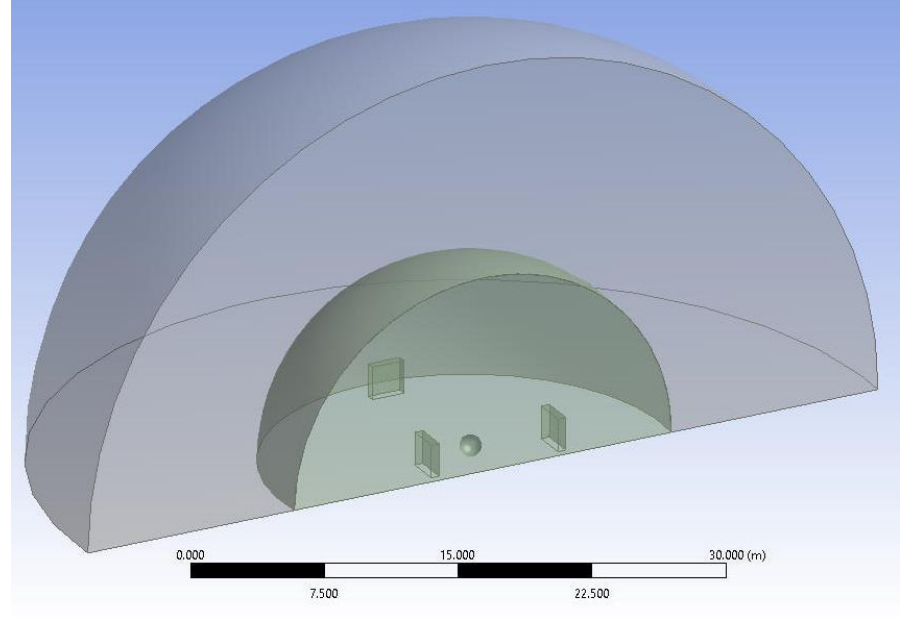
Figure 2. Obstacle distribution geometry when considering an explosion at a vertical wall 1.5 m away from the epicenter.